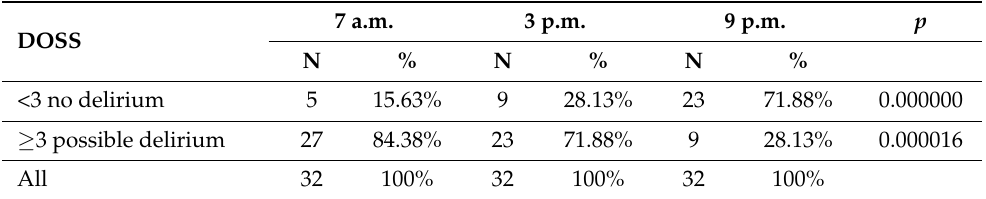
Table 2. Characteristics of groups according to the Delirium Observation Screening Scale (DOSS) in the examined group.